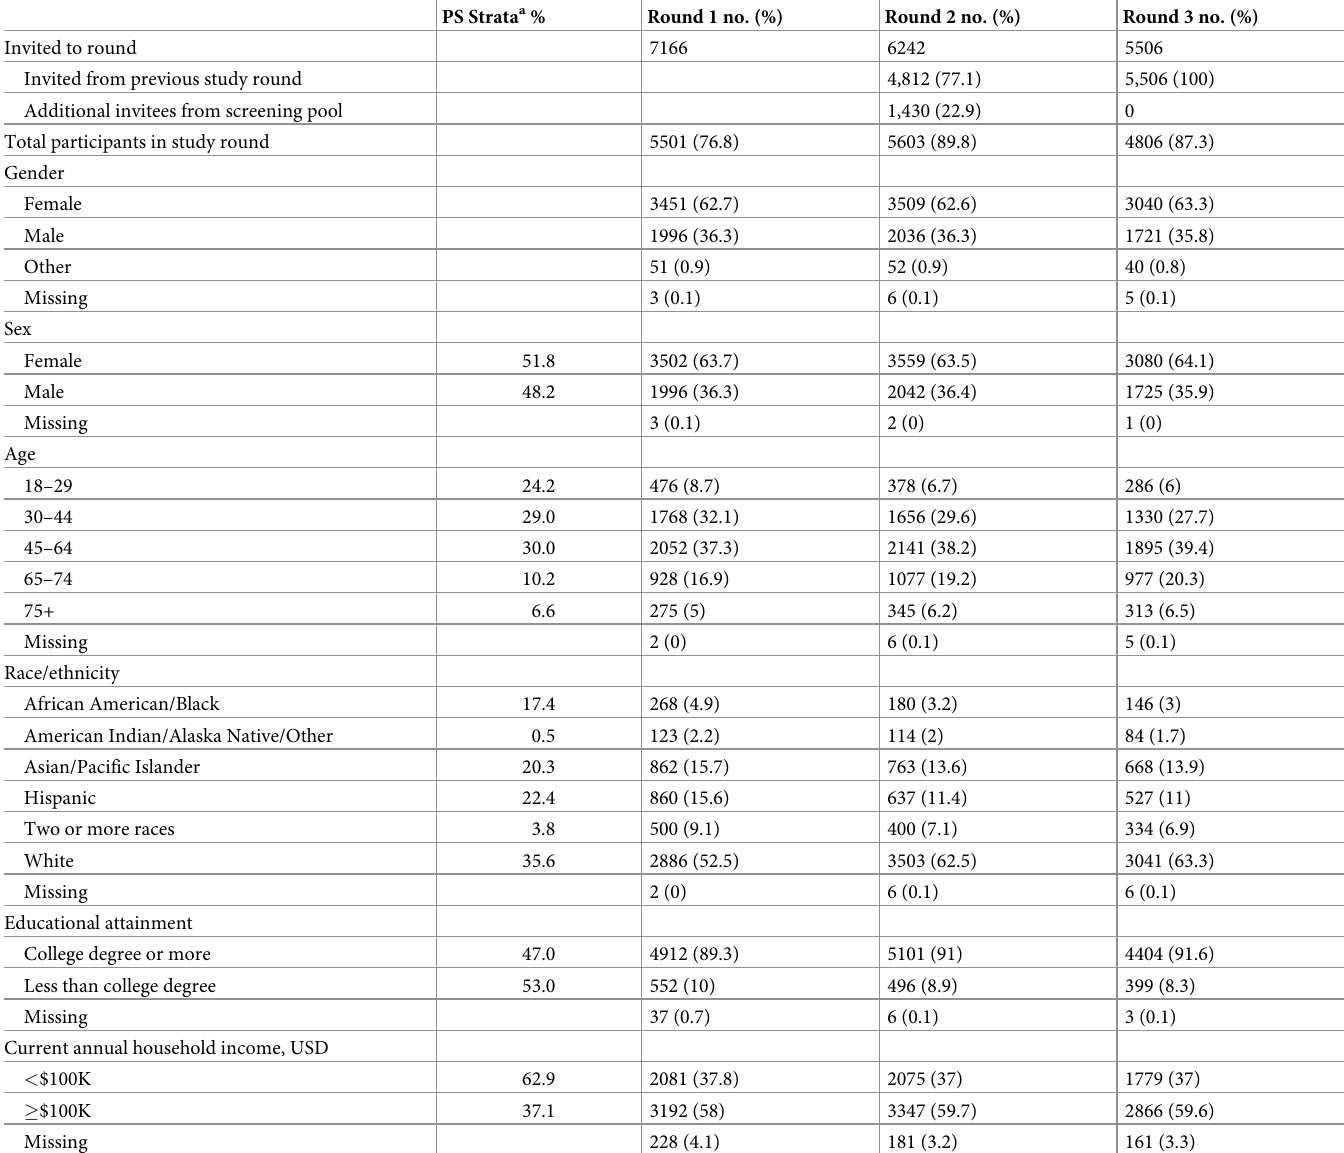
Table 1. Characteristics of participants at each round of the study compared to study region population. PS Strata a % Round 1 no. (%) Round 2 no. (%) Round 3 no.